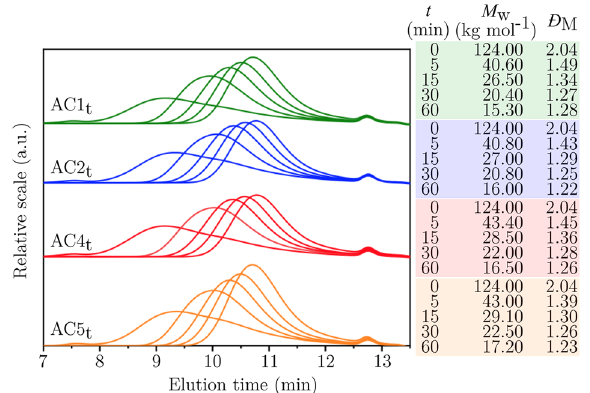
Fig. 4 SEC-RI chromatograms of HC treated PVOH samples - time dependent cavitation treatments. Each colour series shows SEC-RI chromatograms obtained after 0, 5, 15, 30 and 60 min (left to right). Conditions applied: HC1 t (25 °C), HC2 t (25 °C + H 2 O 2 ), HC5 t (60 °C + H 2 O 2 ). Right columns show treatment time t, M w and Đ M